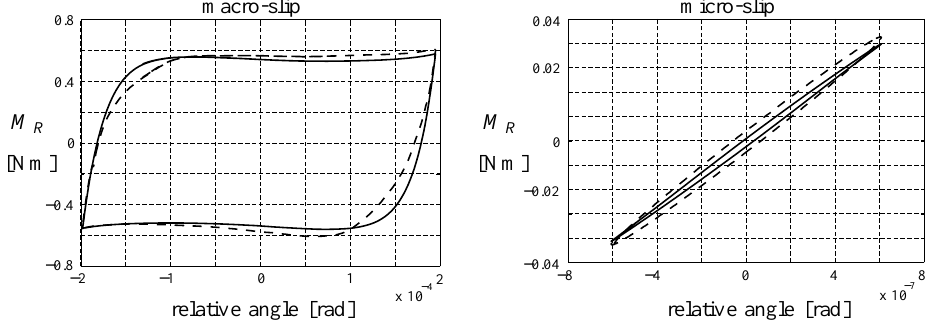
Fig. 5. Hysteresis loops for type B: simulation (—), experiment (– –